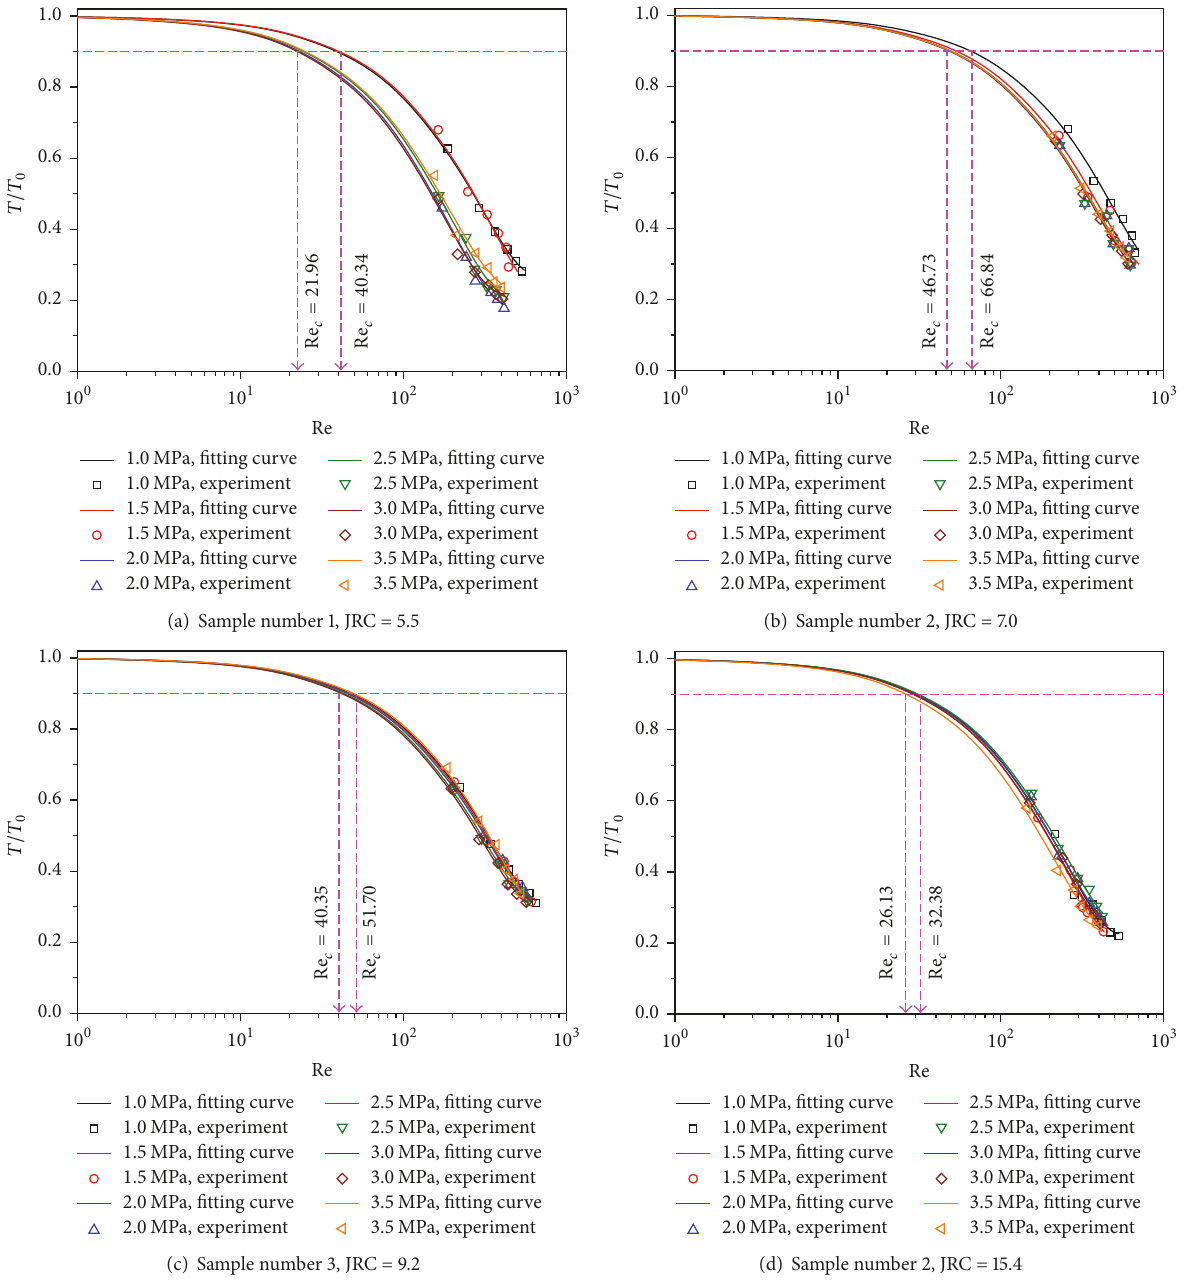
Figure 9: Relationships between T / T 0 and Re based on the data replotted from Zhang and Nemcik ([111], Figure 8 ).